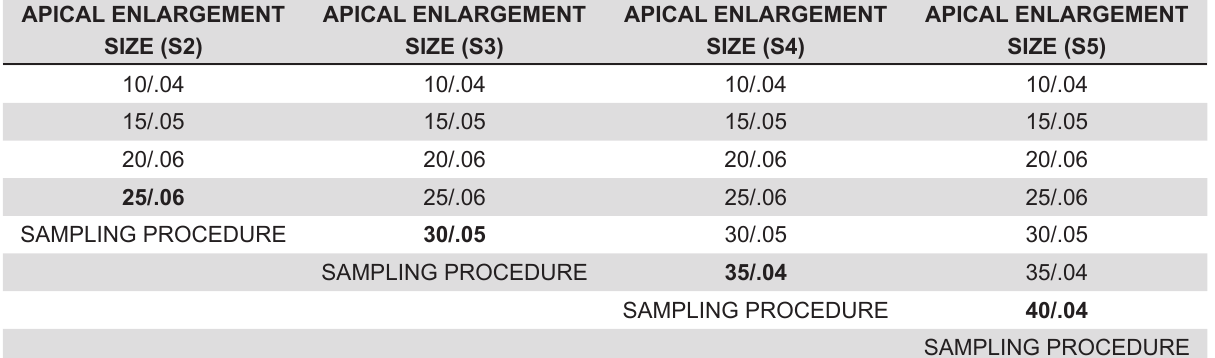
Table 1- Evaluation of increasing apical enlargement of Mtwo ® rotary files on endotoxin